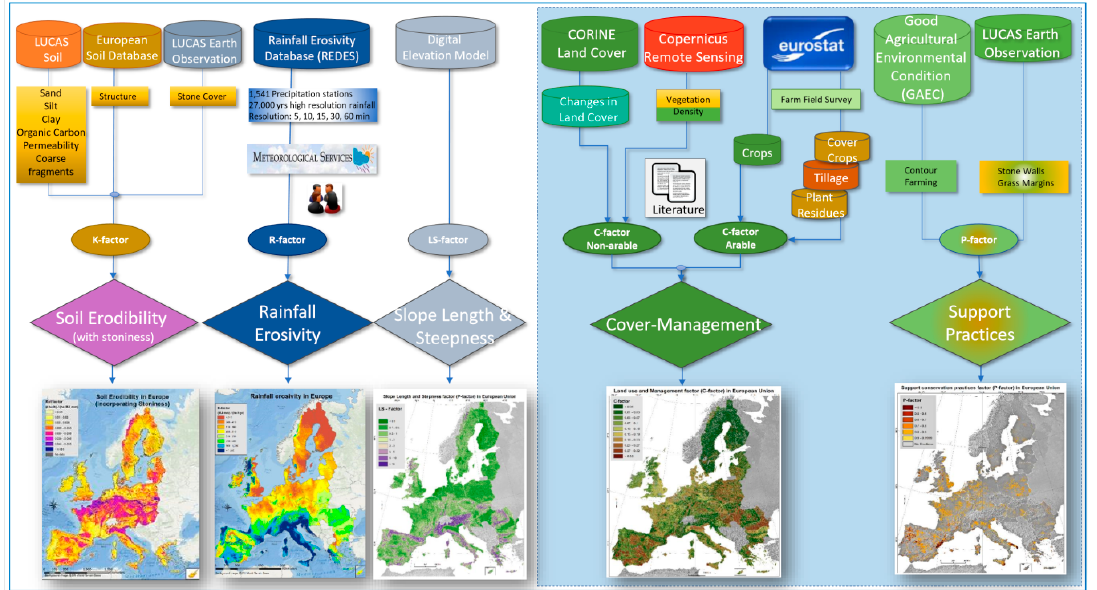
Figure 2. Description of RUSLE2015 model adapted to produce the soil erosion indicator for 2016 (shaded right part is the dynamic component).